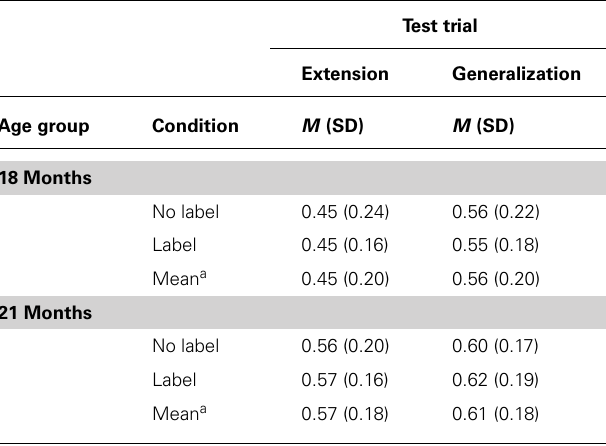
Table 6 | Logistic regression analysis predicting test performance from productive vocabulary, age group, and condition (generalization trial). Predictor